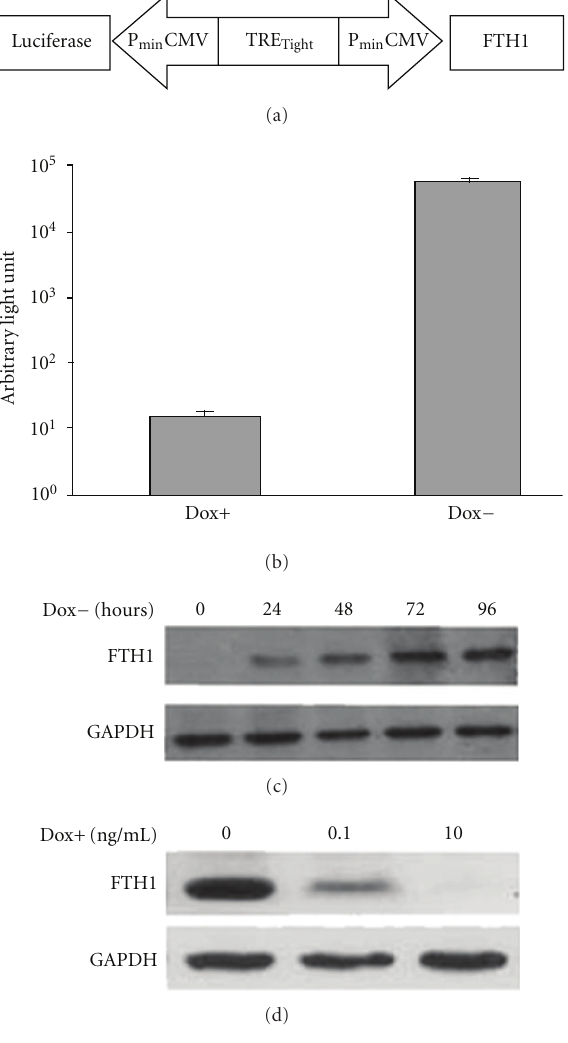
Figure 1: Doxycycline-regulated expression of luciferase and FTH1 in NPC S18 cells. (a) The schematic for the preparation of pTRE-Tight-BI-Luc-FTH1 used to generate the double-stable cell line, B-7, which could inducibly express luciferase and FTH1 simultaneously under the control of same promoter. (b) Luciferase activity induced by doxycycline. B-7 cells were grown in presence (Dox+) or absence (Dox − ) of 10 ng/mL doxycycline for 48h. Cells were analyzed for luciferase activity. Data were expressed as mean ± SD from 3 experiments. (c) Time-dependent FTH1 expression. B-7 cells grown in Dox containing medium were transferred to medium without Dox and grown for di ff erent durations. (d) Doxycycline dose-dependent FTH1 expression. B-7 cells were grown in medium containing doxycycline at di ff erent concentrations for 96 h. FTH1 was determined by Western blot assay. Dox, doxycycline.